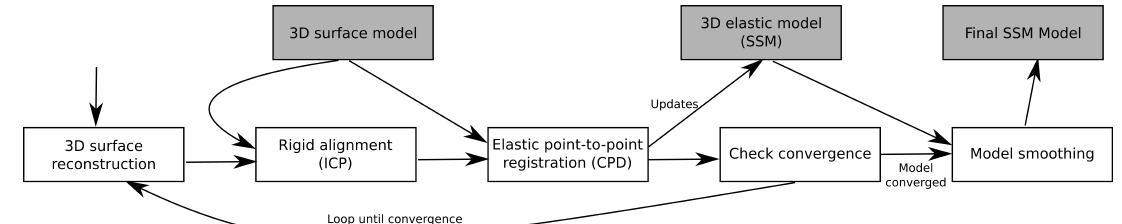
Figure 2. Statistical Shape Model(SSM) Training diagram, that describes the process.